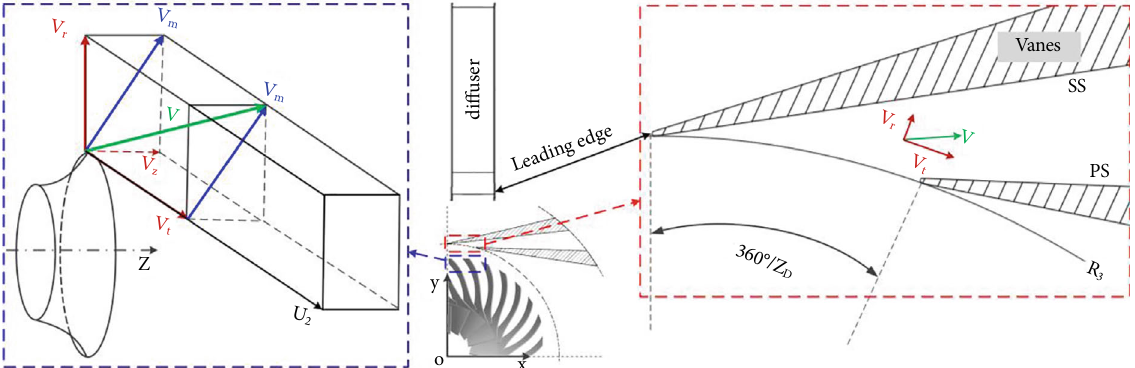
Figure 6: Schematic diagram of velocities.